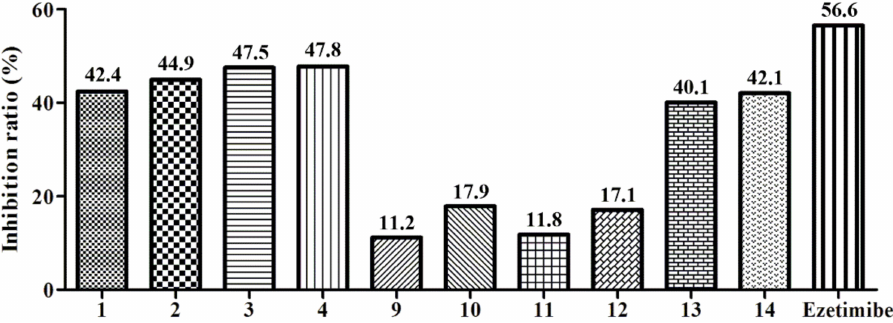
Figure 2. Compounds 1 – 4 and 9 – 14 at the concentration of 100 µ M, the rate of inhibition of cholesterol esterase. Ezetimibe was used as a positive control.